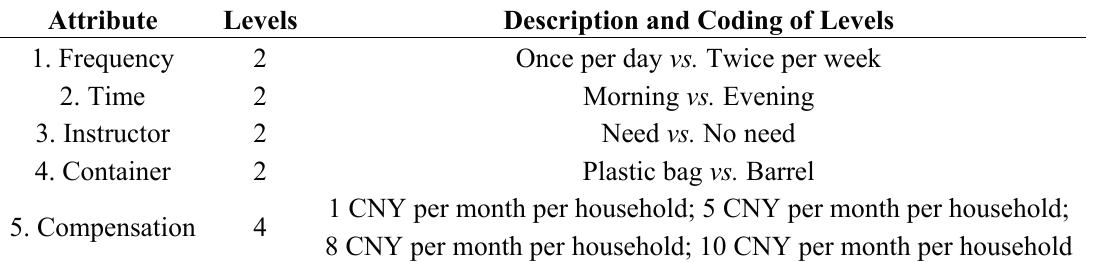
Table 1. Attributes of household kitchen waste separation services and their levels used in choice experiment (CM)